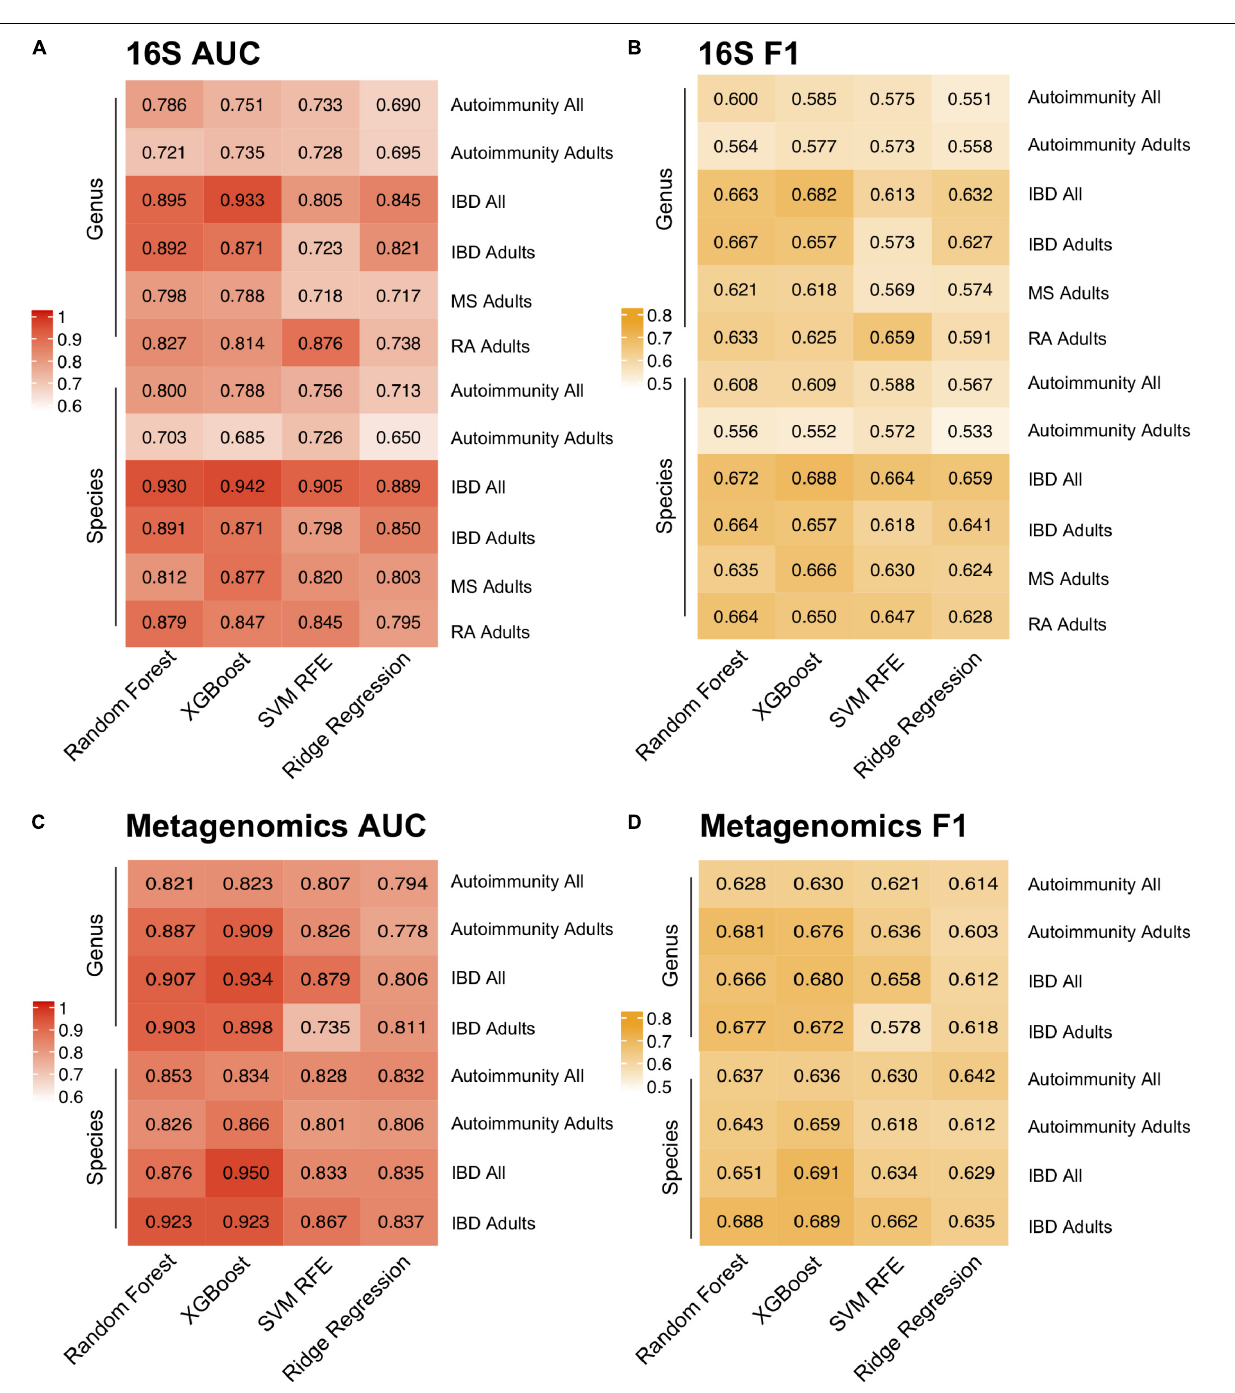
predicting the three distinct autoimmune diseases as well as general autoimmunity. From this, we identified features that were ranked highly by all four algorithms. The top 30 features